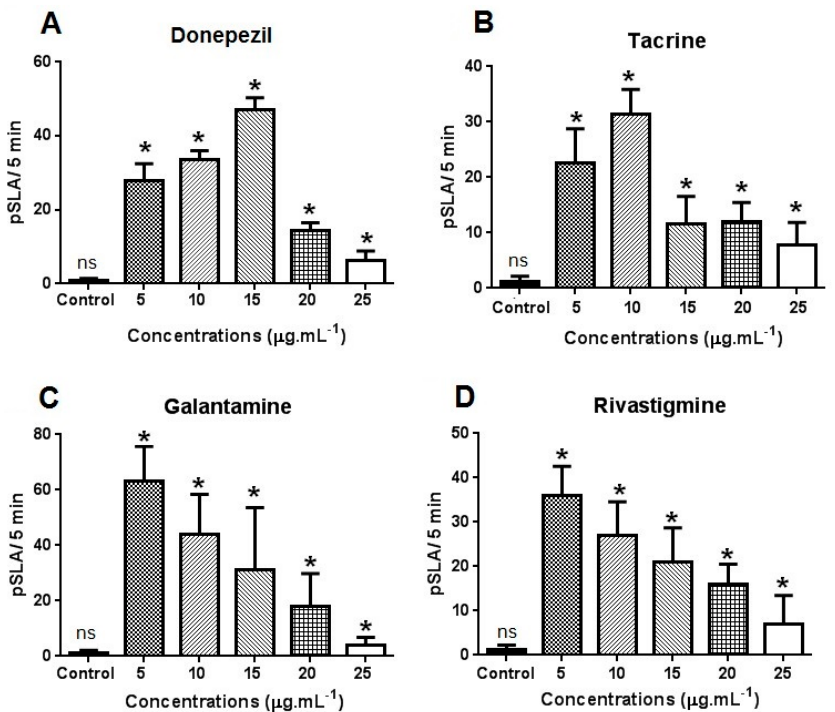
Figure 2. Effects of donepezil ( A ), tacrine ( B ); rivastigmine ( C ) and galantamine ( D ) on planarian seizure-like activity (pSLA) in Dugesia tigrina , after 5 min of exposure. Samples were tested in triplicate with 30 planarians in each Petri dish after 24 h of exposure. * Means differ by Dunnett’s test ( p = 0.05).